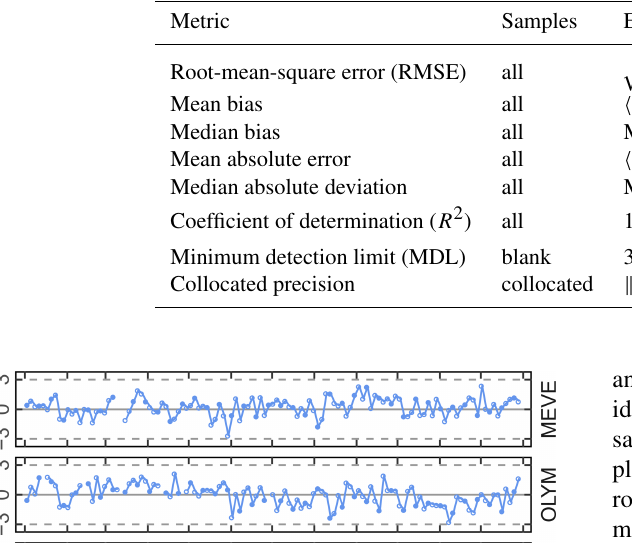
Table 1. Definition for figures of merit for overall assessment of prediction error, samples to which they are applied, and their reference distribution (if available) used for significance testing. y is the (mean-centered) response vector (i.e., TOR OC or EC mass loadings), and ˆ y is the predicted response (Eq. 5). (cid:104)·(cid:105) is the sample mean, Med [·] is the sample median, and Var [·] is the unbiased sample variance. N c is the number of paired collocated samples.